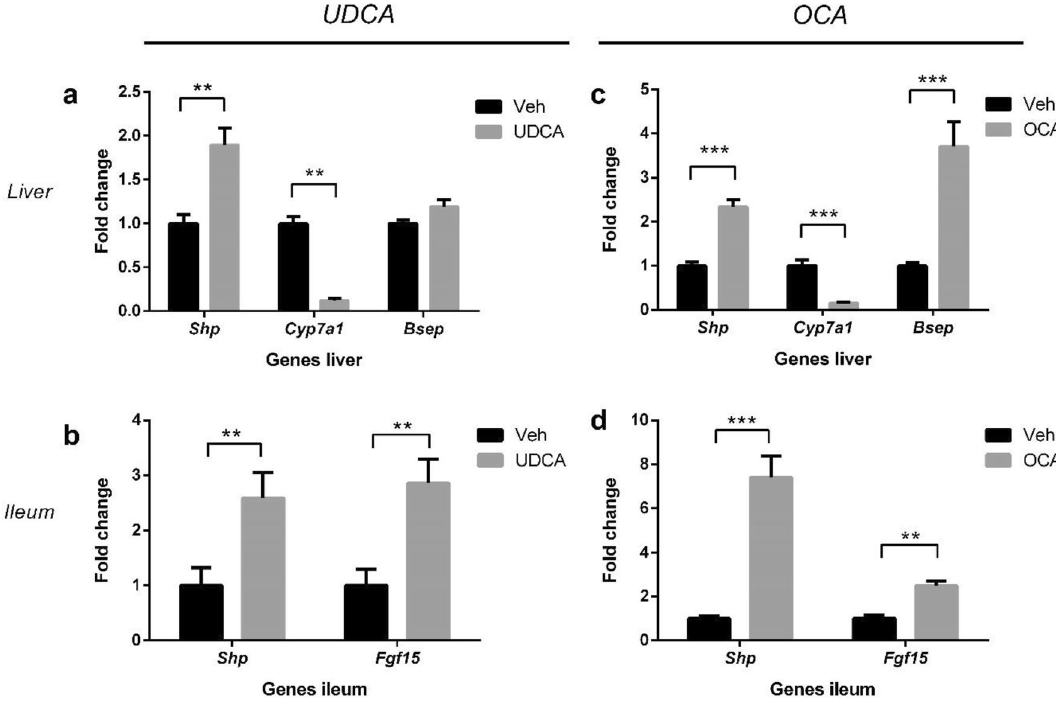
Figure 3. Effect of UDCA and OCA on expression of FXR-target genes in neonatal hUGT1*1 mice. mRNA levels of ( a ) hepatic and ( b ) ileal FXR target genes after vehicle or UDCA; ( c ) hepatic and ( d ) ileal FXR target genes after vehicle or